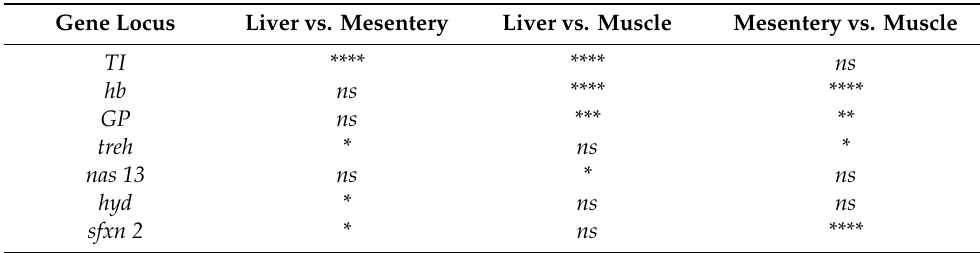
Table 2. Dunnett’s multiple comparison test for di ff erences in gene expression level per target gene between larvae from di ff erent fish host tissues. Significance was fixed at p < 0.05 (* p < 0.05, ** p <